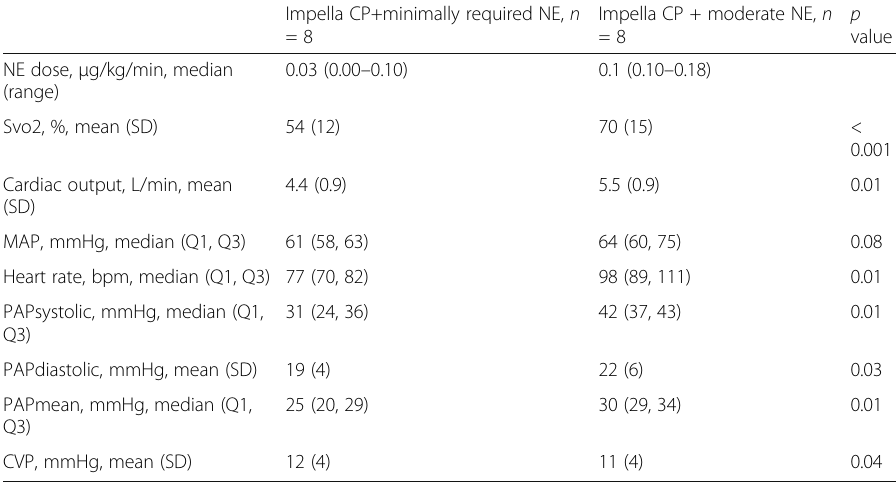
Impella CP+minimally required NE, n = 8 0.03 (0.00 – 0.10) 0.1 (0.10 – 0.18)